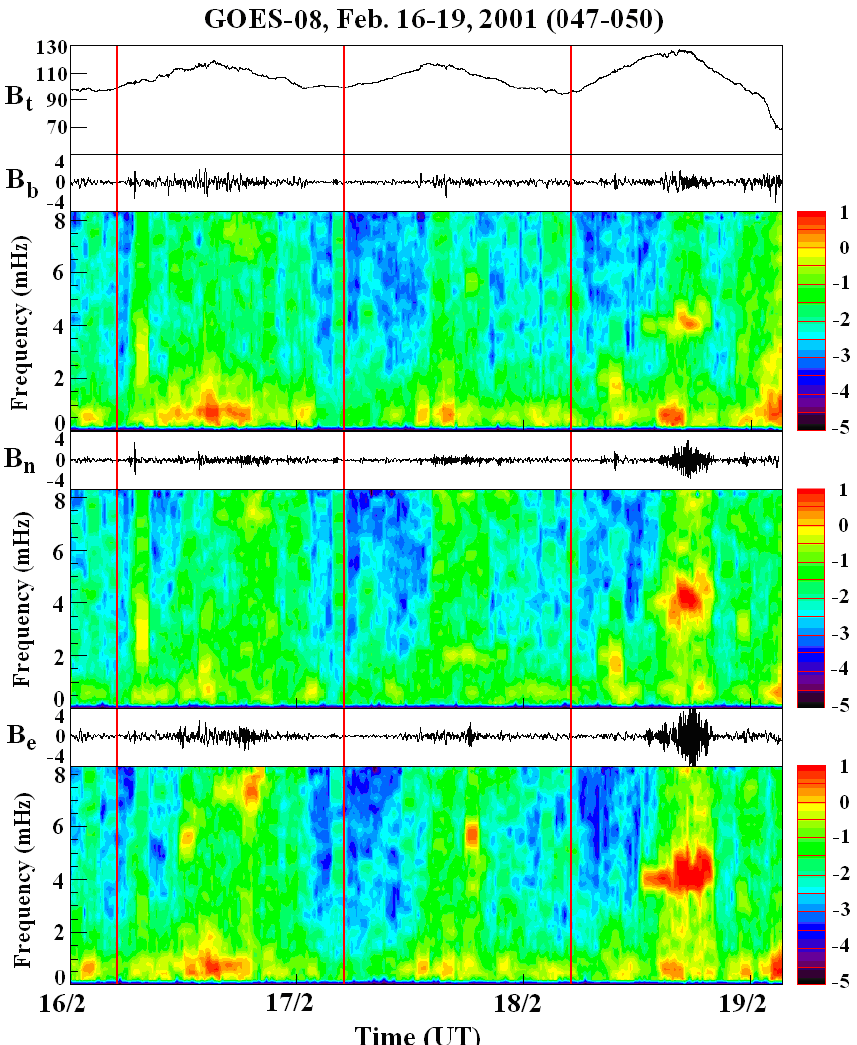
Fig. 1a. The magnetic field of the pulsation measured by GOES-8 from 16 to 18 February 2001 is plotted in the Mean Field-Aligned coordinate system. B t : total magnetic field, B b : field-aligned component, B n : normal – radially outward at the magnetic equator, and B e : eastward. The Dynamic Power Spectra of each component are plotted in color for frequencies up to 8mHz (Pc5 range). The color scale corresponds to the logarithm of the power, in nT 2 /Hz. The red lines correspond to midnight in Local Time, or 05:00